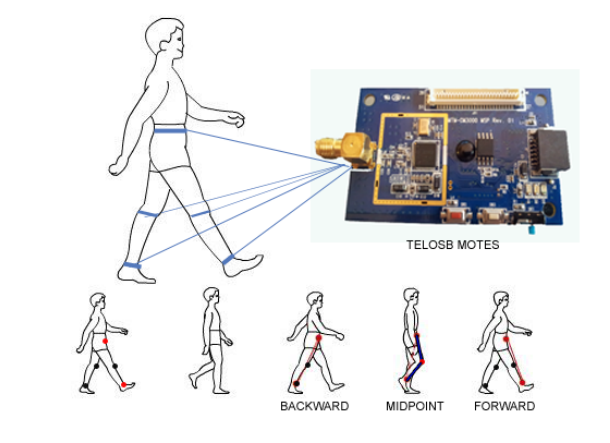
Figure 3: The placement of the sensing nodes and the aggregation node